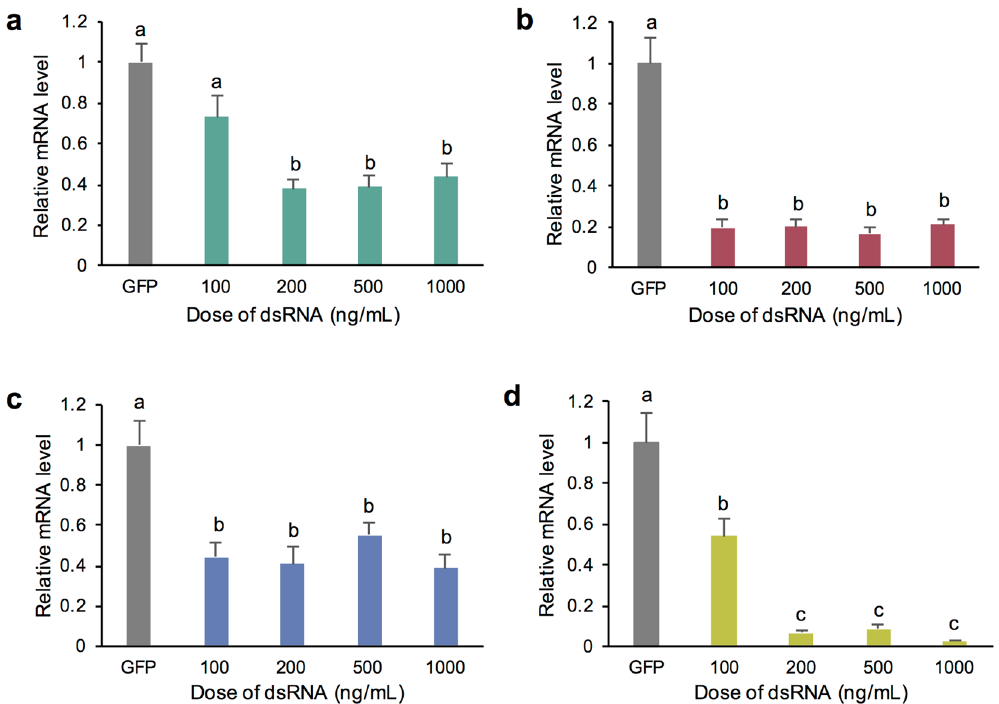
Figure 4. The effect of dsRNA dose on transcript levels in Sclerotinia sclerotiorum in vitro . Transcript levels were measured at time points 0, 24, 48, 72, and 96 hours post treatment of 500 ng/mL of dsRNA targeting SS1G_01703 ( a) , SS1G_05899 ( b) , SS1G_06487 ( c) , SS1G_11912 ( d) , or GFP in liquid culture. Data are relative to GFP-dsRNA control and normalized to reference SsSac7 (SS1G_12350). Data represents 3 biological replicates with error bars representing standard error. To test effect of dosing, a one-way ANOVA (with significance level of p < 0.05) was performed and followed by a Tukey post hoc test to compare means, where significant differences (p tukey < 0.05) are denoted with differing